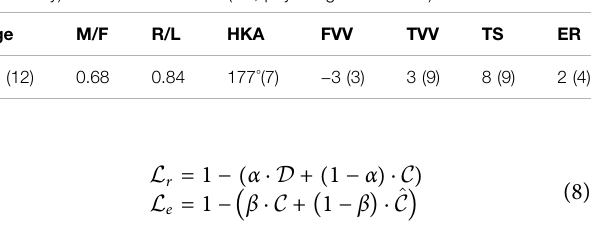
TABLE 1 | Patient data: age range, male/female ratio, right/left ratio. Clinical data reported as mean (SD) value: Hip-knee-ankle (HKA, physiological value: 180 ° ) angle, femoral varus/valgus (FVV, physiological value: 0 ° ) angle, tibial varus/valgus (TVV, physiological value: 0 ° ) angle, tibial slope (TS, physiological value: 7 ° posteriorly) and external rotation (ER, physiological value: 0 °